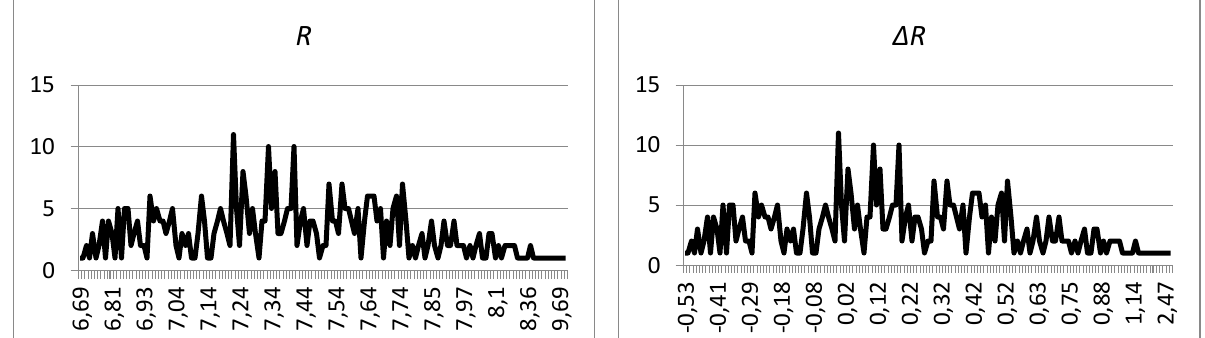
Figure 7 (b). Deviation